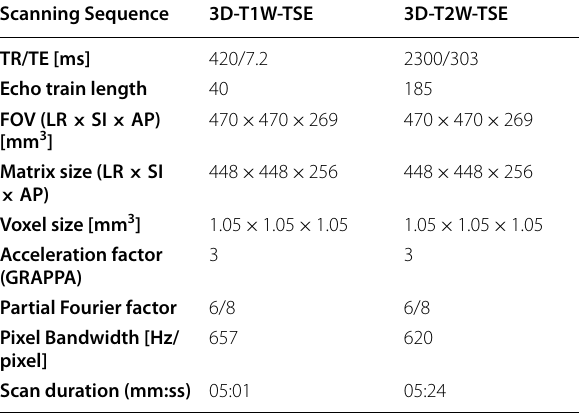
LR Left/right, SI Superior/inferior, AP Anterior/posterior, GRAPPA Generalized autocalibrating partial parallel